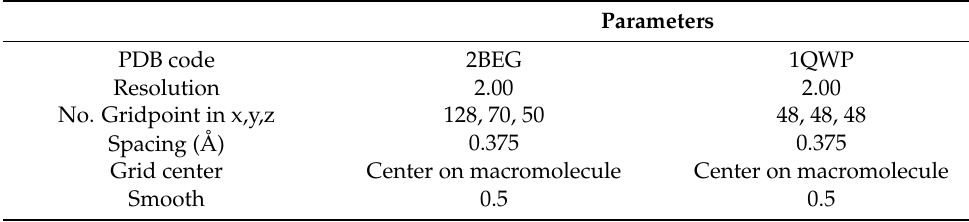
Table 9. AutoGrid